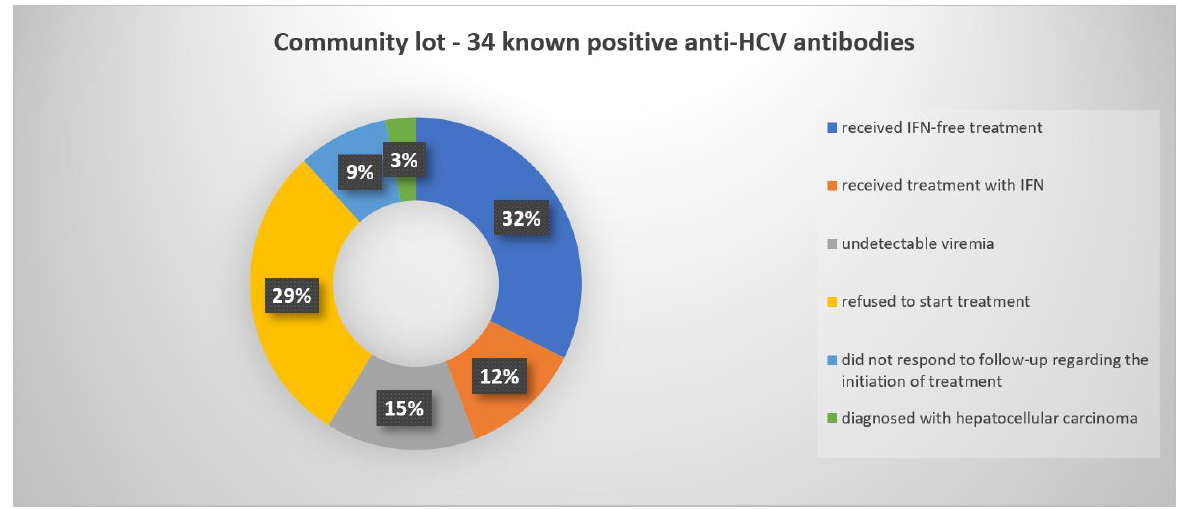
Figure 4. Graphical representation of the status of the 34 persons from the CL with positive anti-HCV antibody results who did not qualify for further treatment.